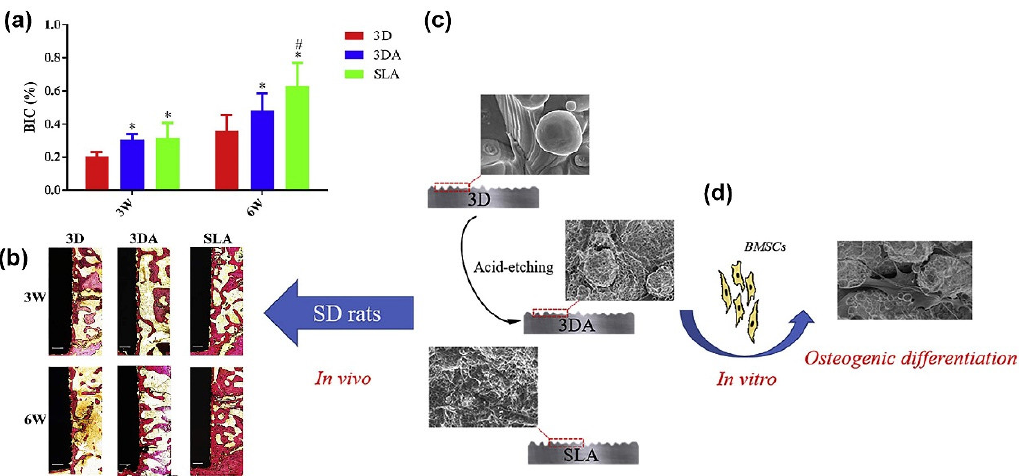
Figure 6. ( a ) Representative histological images of 3D, 3DA, and SLA implants after implantation for 3 and 6 weeks, respectively (scale bar = 200 μm); ( b ) quantification of BIC percentages on